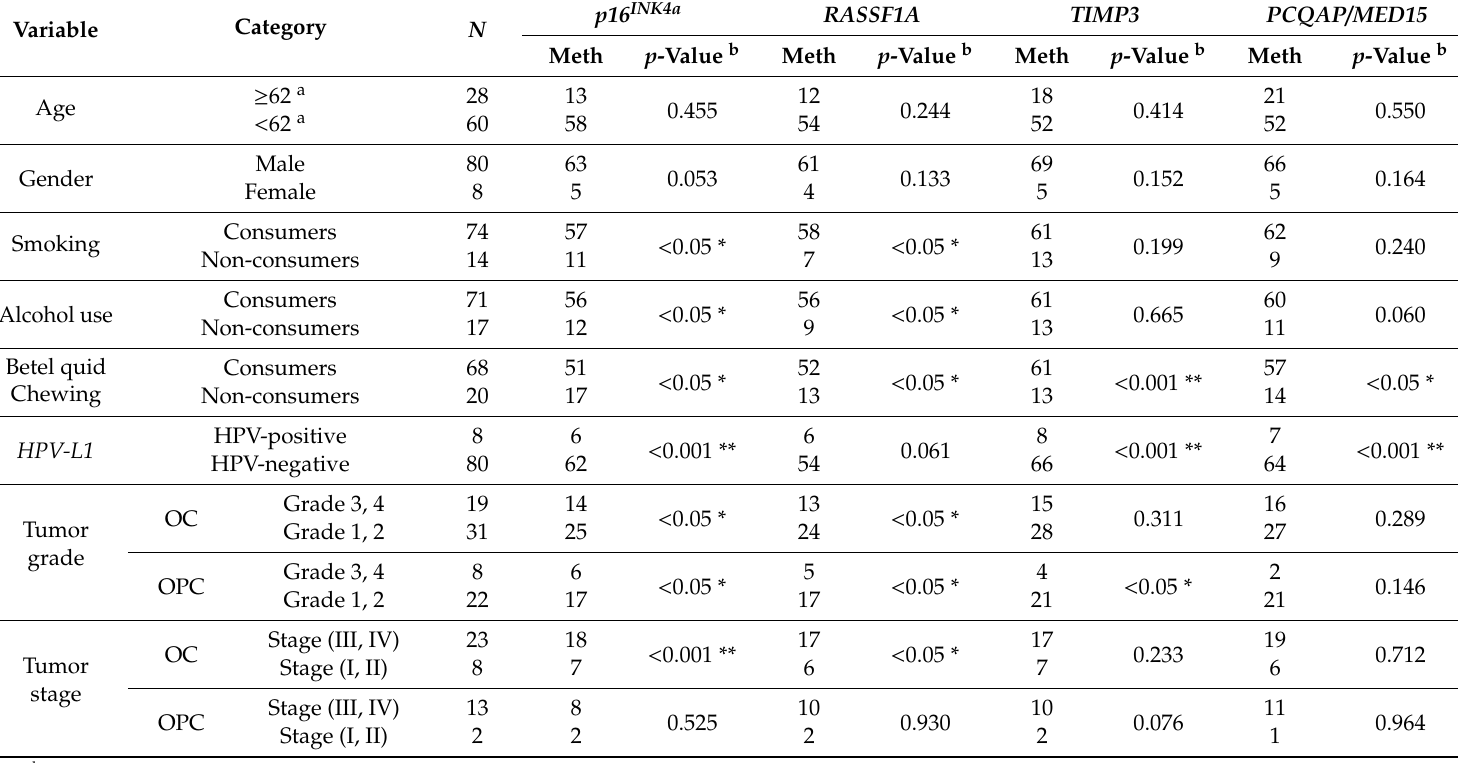
Table 4. Association of promoter hypermethylation of tumor-suppressor genes (TSGs) with demographic factors, risk factors, and clinicopathological characteristics.